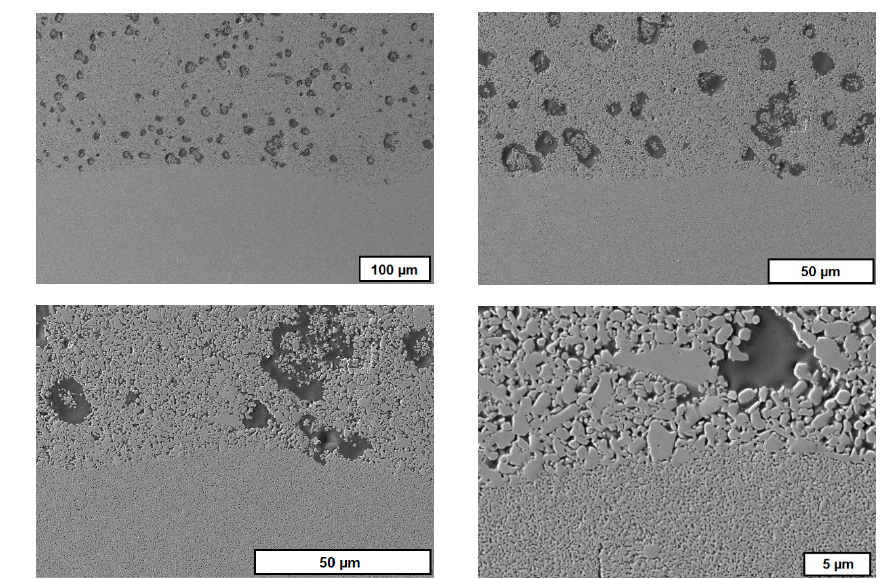
Figure 17. SEM images in different magnifications of cross-sections of sintered ceramic dense porous